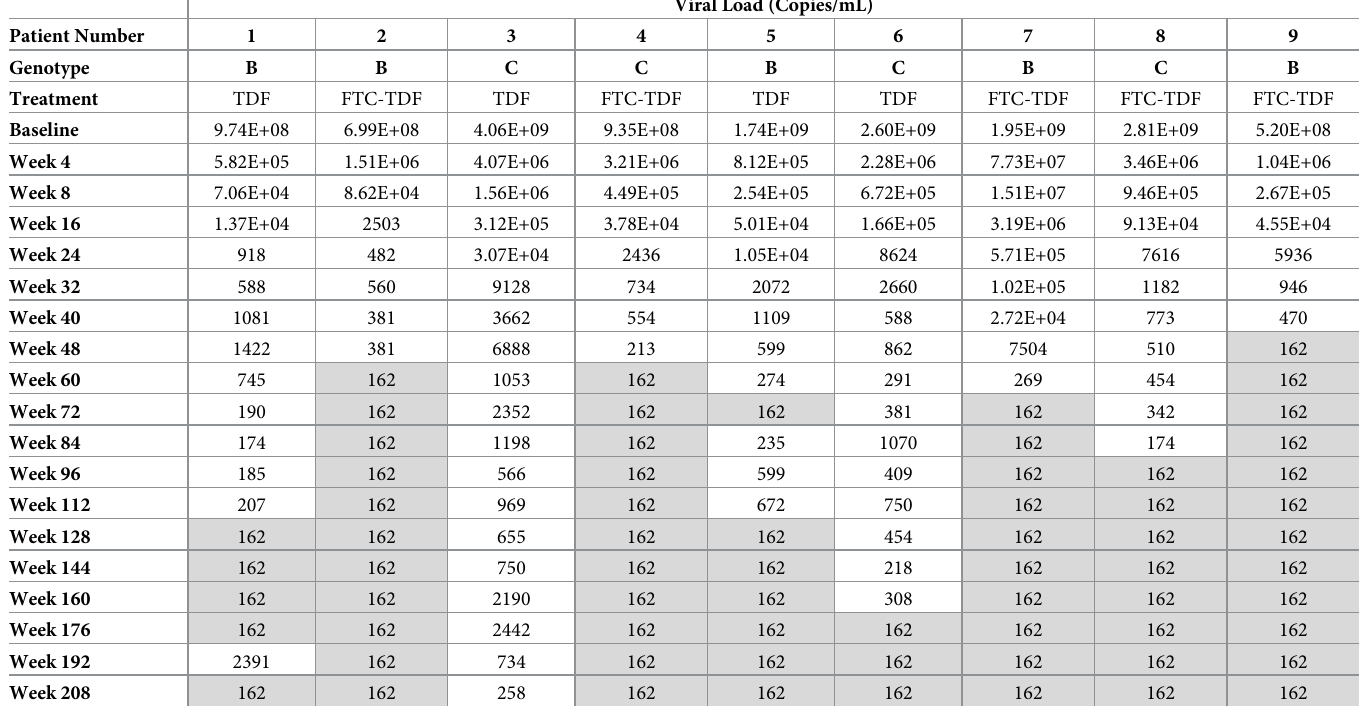
Table 1. Viral kinetics of the patients selected for this study following administration of TDF or TDF/FTC. Timepoints indicate time on NA treatment at which serum was sampled. HBV DNA was measured by Roche TaqMan COBAS at the indicated timepoints (copies/mL). Shaded boxes indicate HBV DNA levels reached LLOQ and are � 162